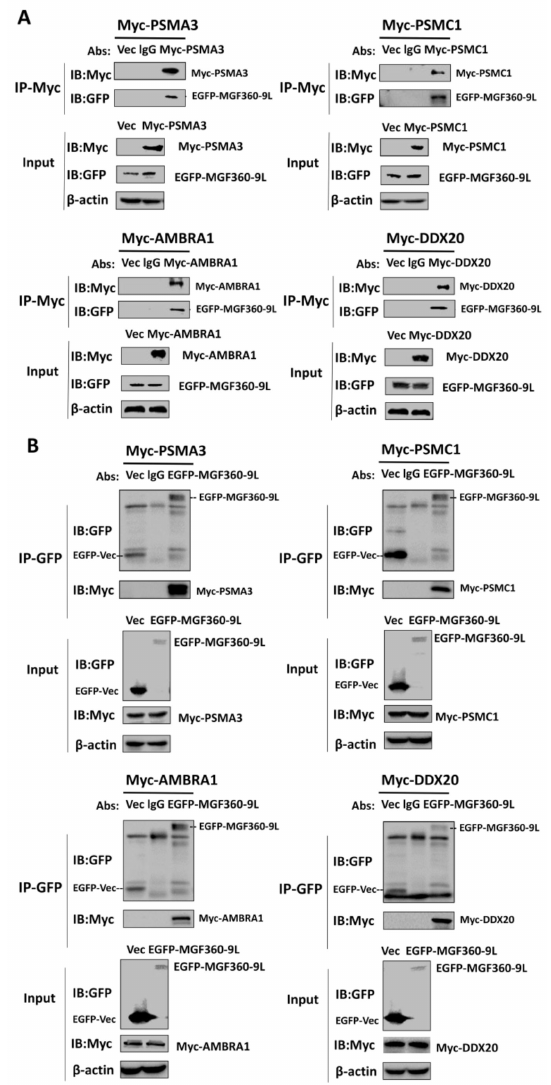
Figure 5. Verification of MGF360-9L-cell protein interaction. ( A ) HEK-293T cells were co-transfected with plasmids expressing Myc-PSMA3, Myc-PSMC1, Myc-AMBRA1, or Myc-DDX20, and plas- mids expressing EGFP-MGF360-9L. EGFP-MGF360-9L was co-transfected with an empty vector as a negative control. Cell lysates were detected by immunoprecipitation with lgG and anti-Myc monoclonal antibodies, SDS-PAGE separation, and western blotting and detected with corresponding antibodies. β -actin was used as an internal loading control. ( B ) HEK-293T cells were co-transfected with plasmids expressing Myc-PSMA3, Myc-PSMC1, Myc-AMBRA1, or Myc-DDX20, and plasmids expressing EGFP-MGF360-9L. Plasmids expressing Myc-PSMA3, Myc-PSMC1, Myc-AMBRA1, or Myc-DDX20 and empty vector pCDNA3.1(+)-EGFP-C were used as a negative control. Cell lysates were detected by immunoprecipitation with lgG and anti-GFP monoclonal antibodies, SDS-PAGE separation, and western blotting and detected with corresponding antibodies. β -actin was used as an internal loading